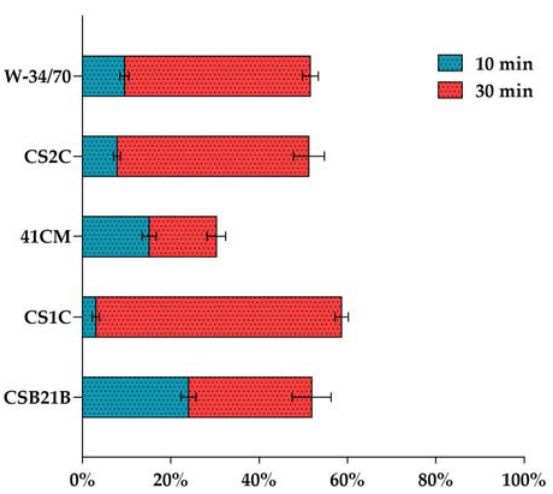
Figure 1. Flocculation capacity (%) of S. cerevisiae CSB21B, CS1C, CS2C, 41CM and S. pastorianus W-34/70 strains after 10 min and 30 min at 15 °C.